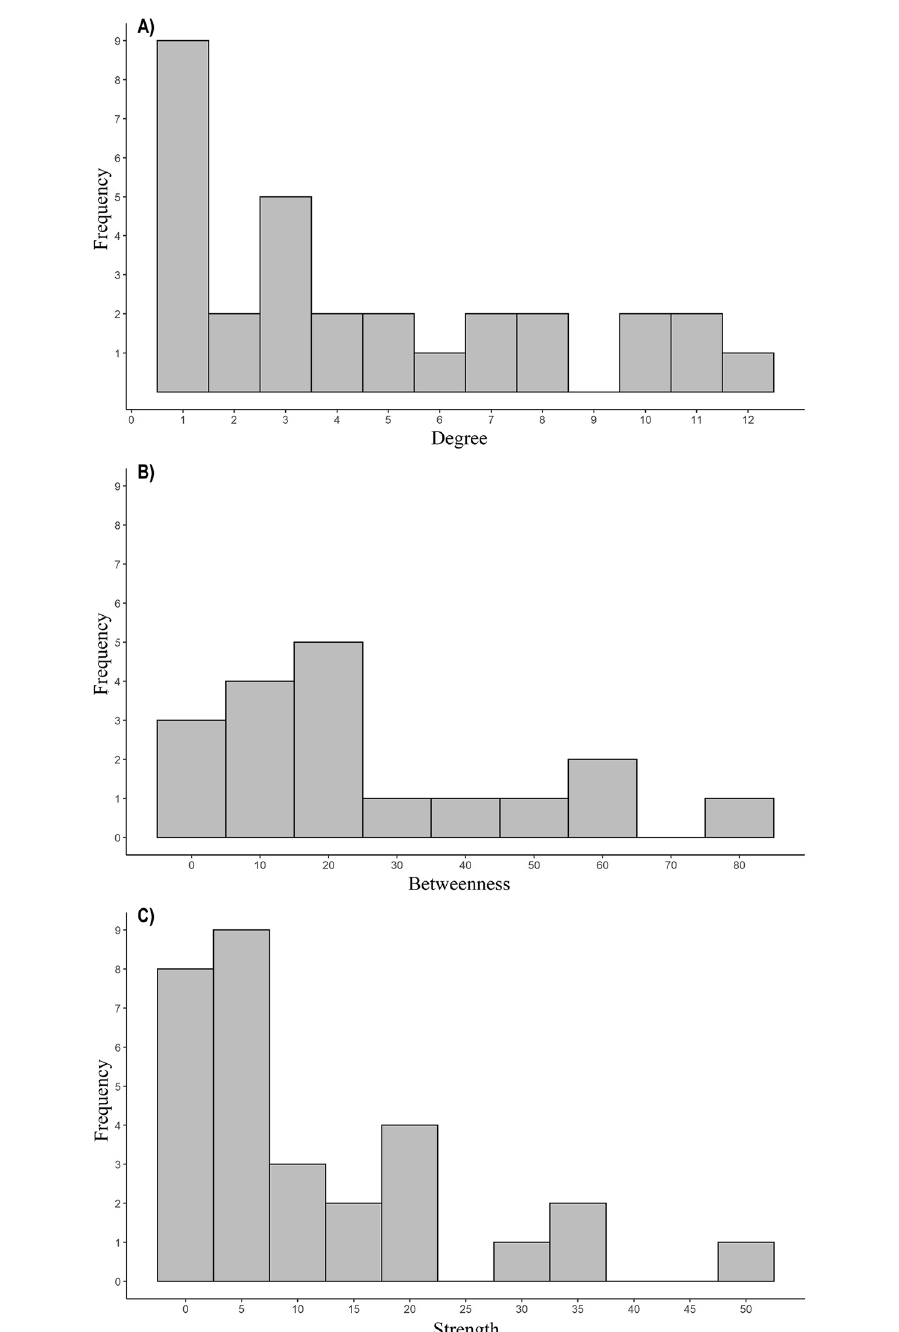
Fig. 3 Distribution of social metrics for site 1 (n = 30). (A) Degree denotes the number of individuals interacting with a specific lizard. For M. atacamensis , highly central individuals are the five individuals with the highest degree values (i.e., the right tail of the x-axis). (B) Betweenness indicates the number of shortest paths between all possible pairs of animals that pass through a focal animal. A few highly central individuals have high betweenness values, while a majority of lizards have betweenness closer to 0. (C) Strength values indicate the total number of interactions for each